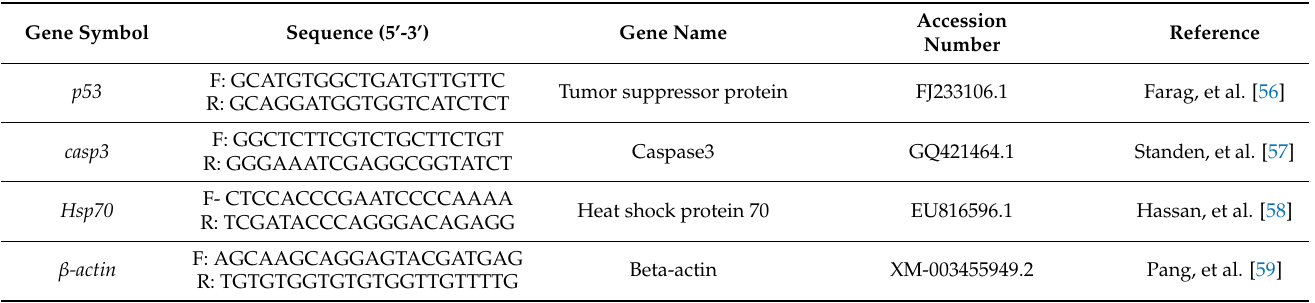
Table 1. Primer sequences (forward and reverse) used for expression